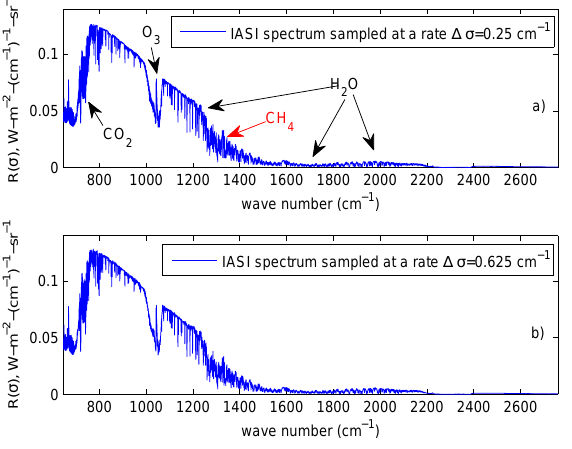
, CH , H O and O 2 4 2 3